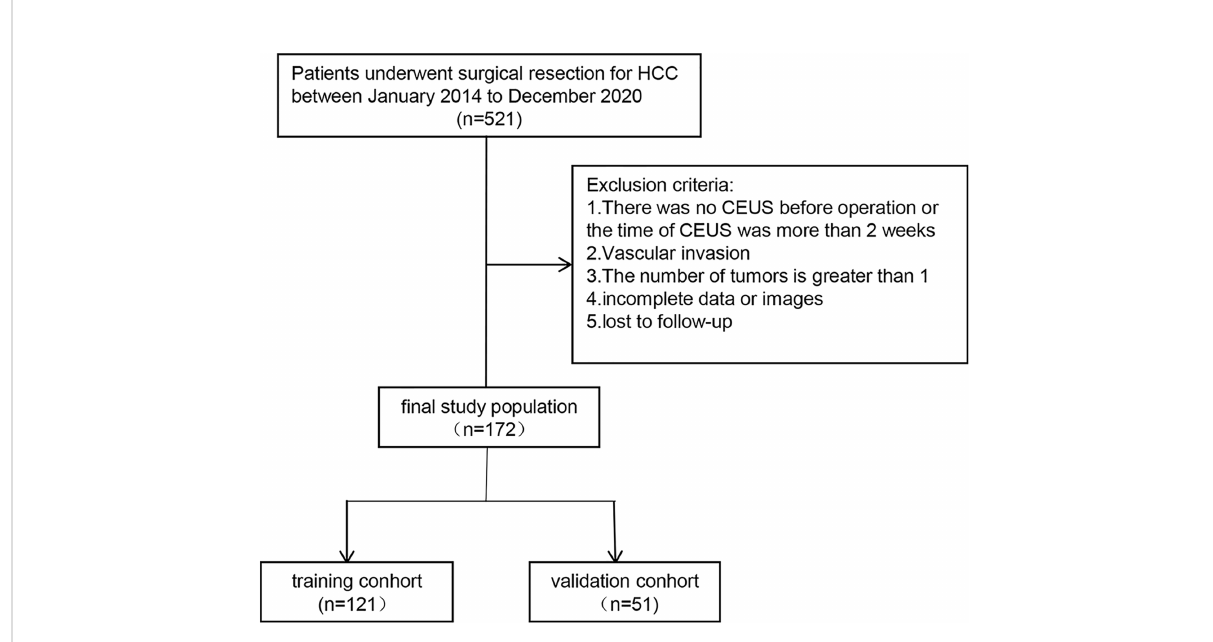
FIGURE 1 The fl ow chart is